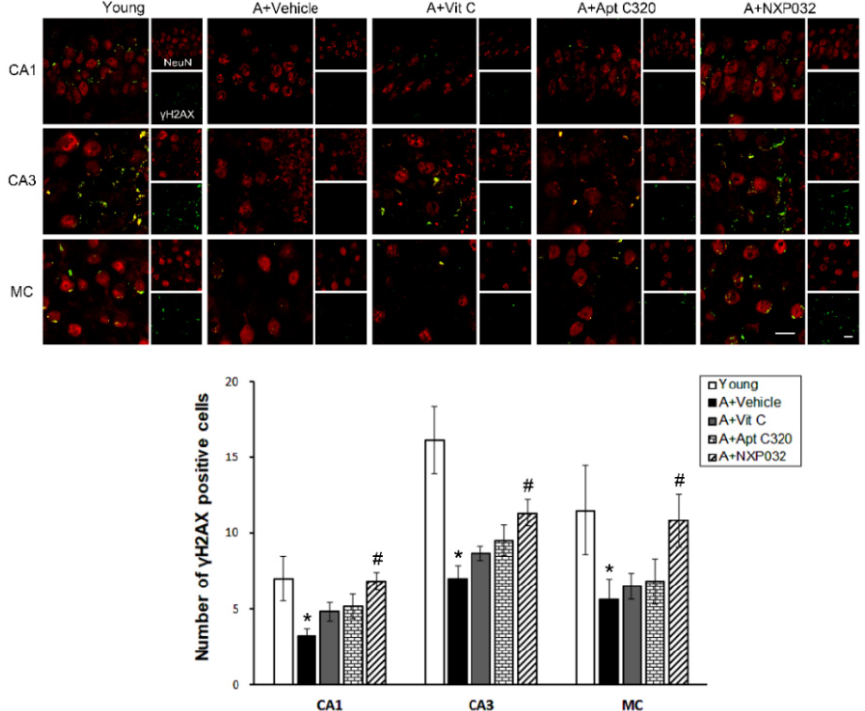
Figure 6. Effect of NXP032 on aging-induced γ H2AX expression in the brain. Representative photographs of immunofluorescence staining of γ H2AX (green) and NeuN (red) in the brain. The aging mice had a significantly reduced number of γ H2AX in the hippocampal CA1, CA3, and MC regions. NXP032-treated mice had a significantly higher number of γ H2AX in the hippocampal CA1, CA3, and MC regions than in the vehicle-treated mice. In the vit C and Aptamin 320-treated groups, the number of γ H2AX did not increase in hippocampal CA1, CA3, and MC regions. The data are presented as the mean ± S.E.M. * p < 0.05, compared to the young group. # p < 0.05, compared to the aging-vehicle group. Scale bar: 20 µm.